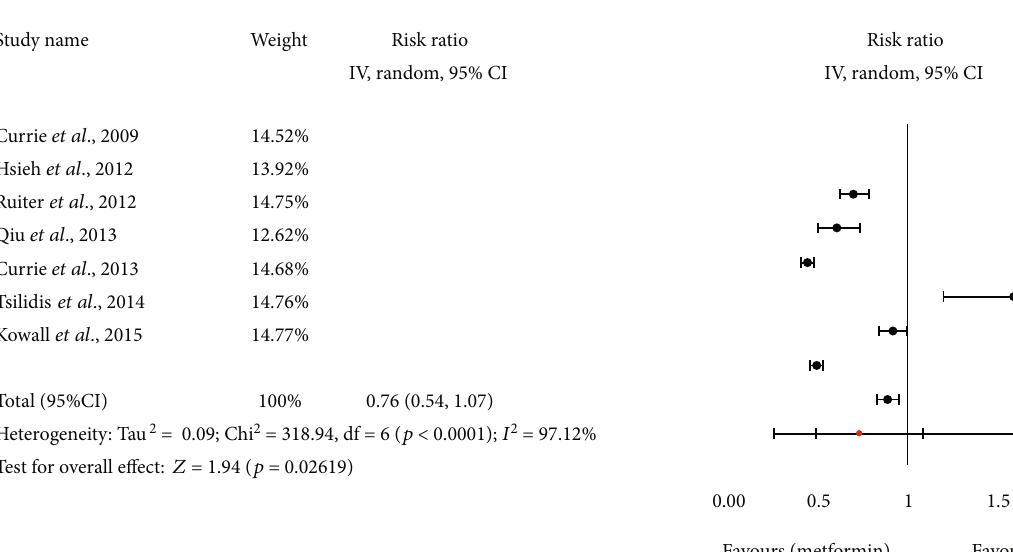
Figure 2: Forest plot of the relative risk of cancer when comparing the use of monotherapy with metformin versus SUs, using the raw data. Black circles represent study-speci fi c relative risk estimates (size of the blue circle re fl ects the study-speci fi c statistical weight, that is, the inverse of the variance); horizontal lines represent 95% CIs; red circle represents summary relative risk estimates with corresponding 95% CIs; p values are from testing for heterogeneity across study-speci fi c raw case data. Abbreviations: CI: con fi dence interval; SU: sulfonylurea. Overall cancer incidence (adjusted)